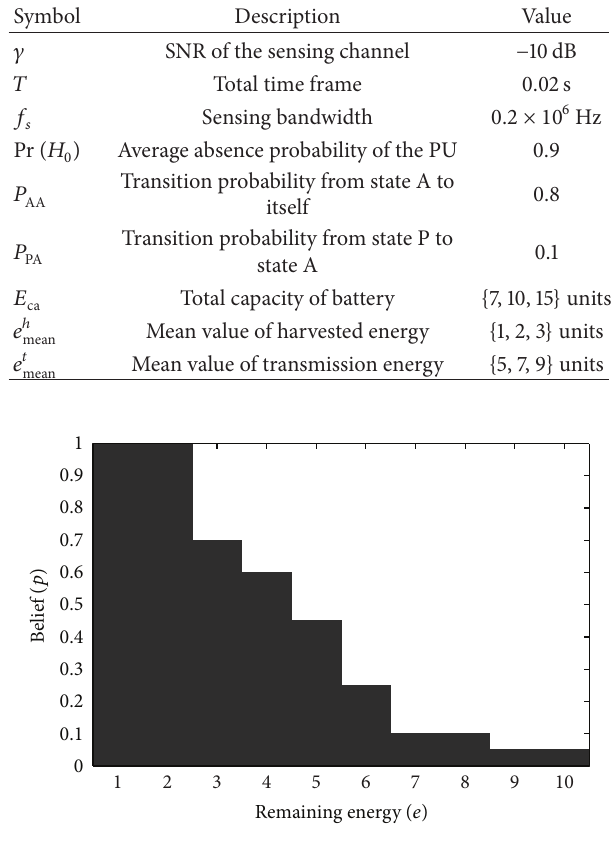
Figure 3: The optimal mode decision policy when 𝐸 = 7 (black area: sleeping mode and white area: accessing 2 , and 𝑒 𝑡 mean